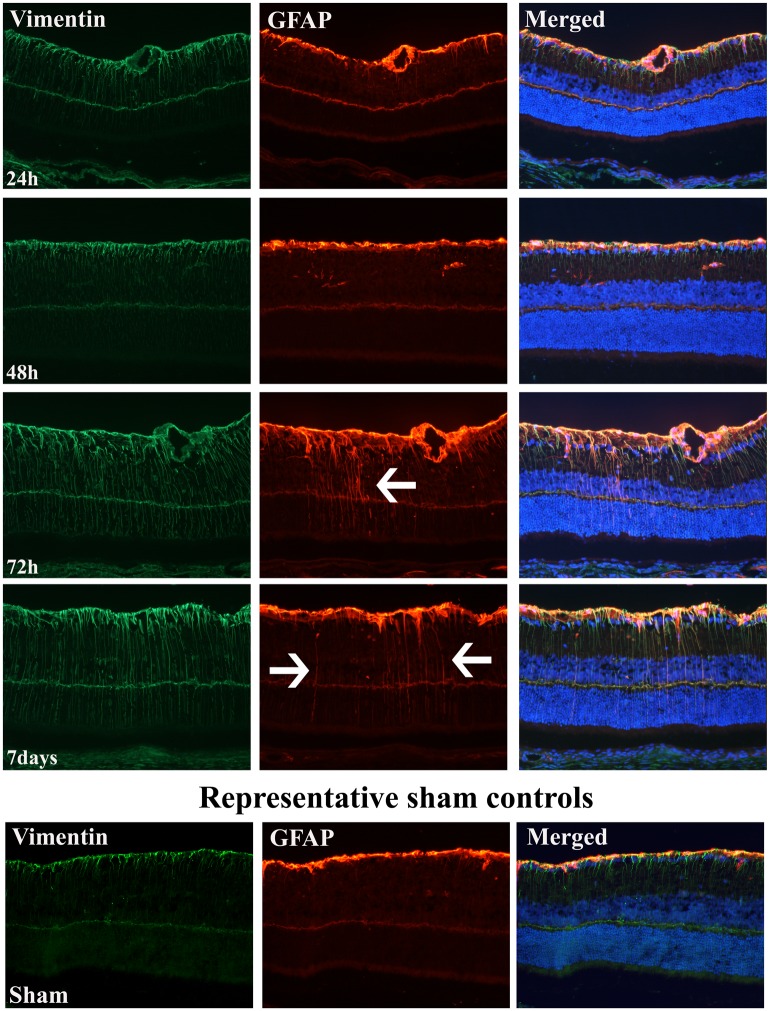
Increased GFAP and vimentin expression 72 hours and 7 days post ischemia.Increased GFAP and vimentin expression 72 hour and 7 days after transient global ischemia (1 day n = 4, 48h n = 8, 72h n = 4, 7 day n = 8). Arrows highlight GFAP positive staining spanning throughout the retina. Even though there was an increase in vasoconstriction on the ophthalmic artery at 48 hours, it took 72 hours for the retina to show signs of gliosis through Müller cell markers GFAP and vimentin upregulation. Müller cells were still active at 7 days after ischemia.